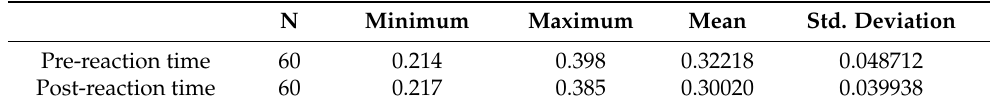
Table 2. Real-life reaction time of the